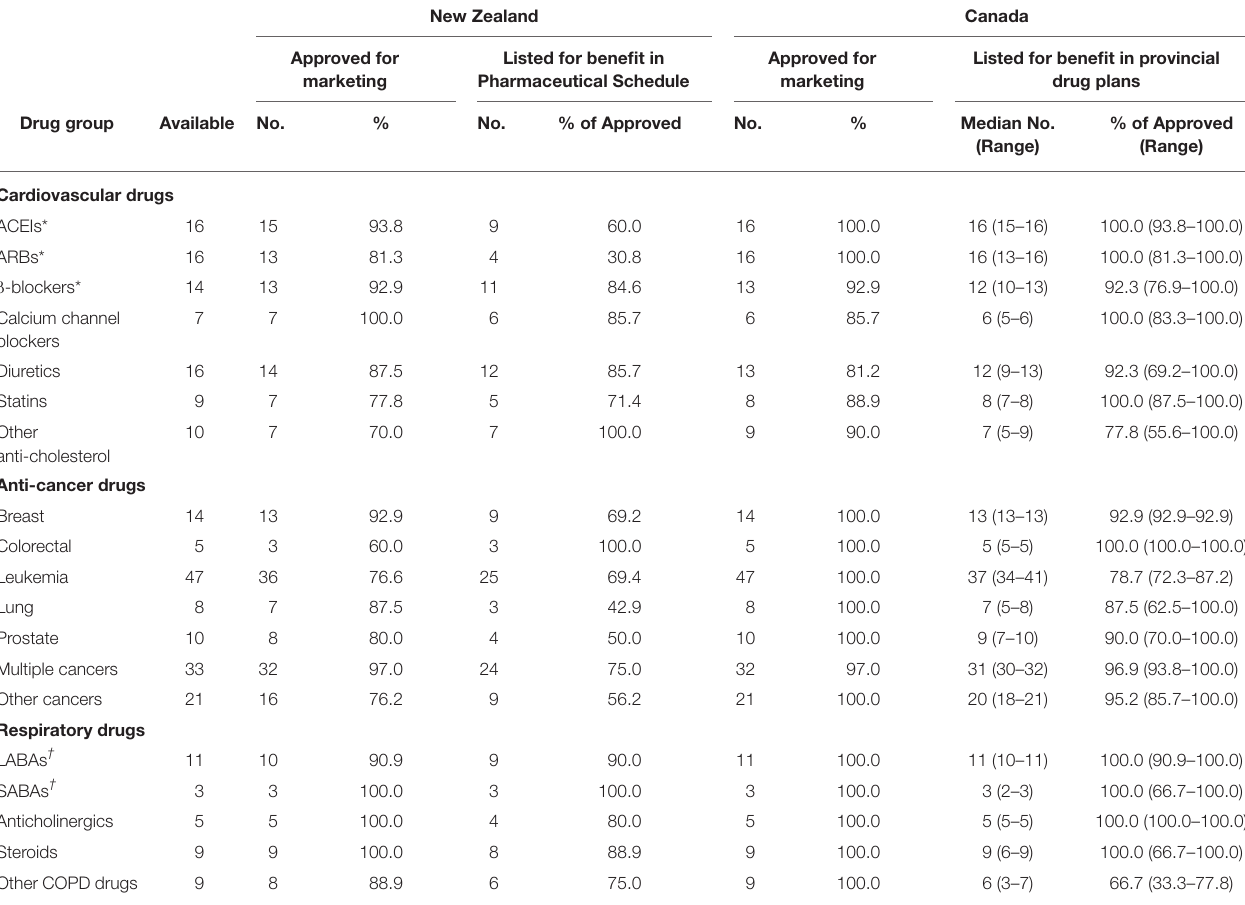
TABLE 2 | Summary results of the comparison of selected drugs approved and listed for benefit in New Zealand and Canada, June